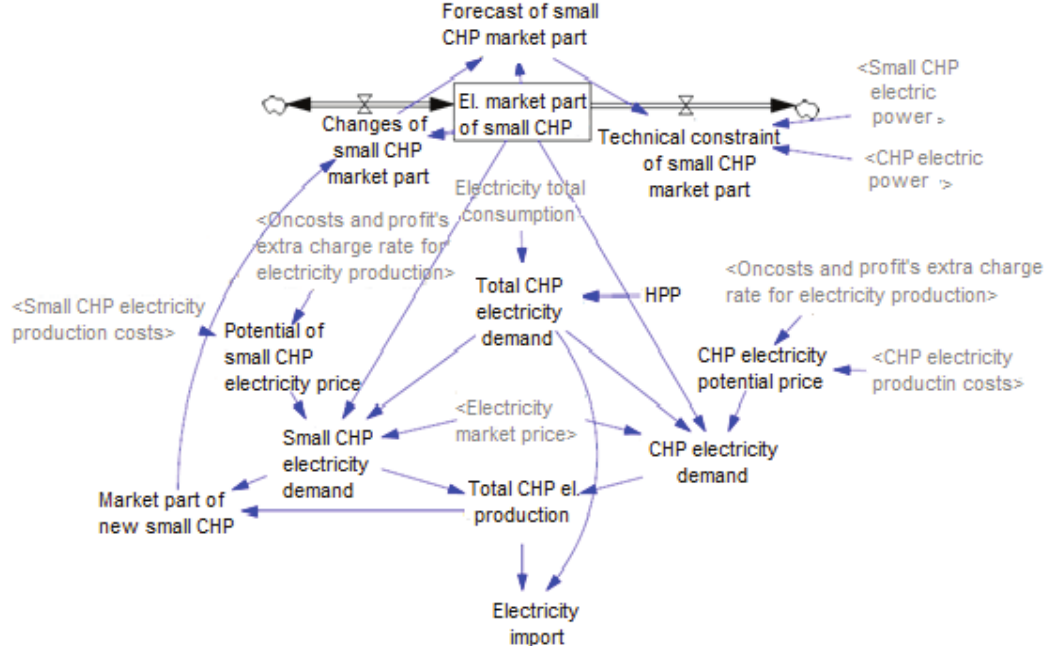
Fig. 4. An example of the system dynamics model: The “Research object” (Latvenergo JSC) sub-block.